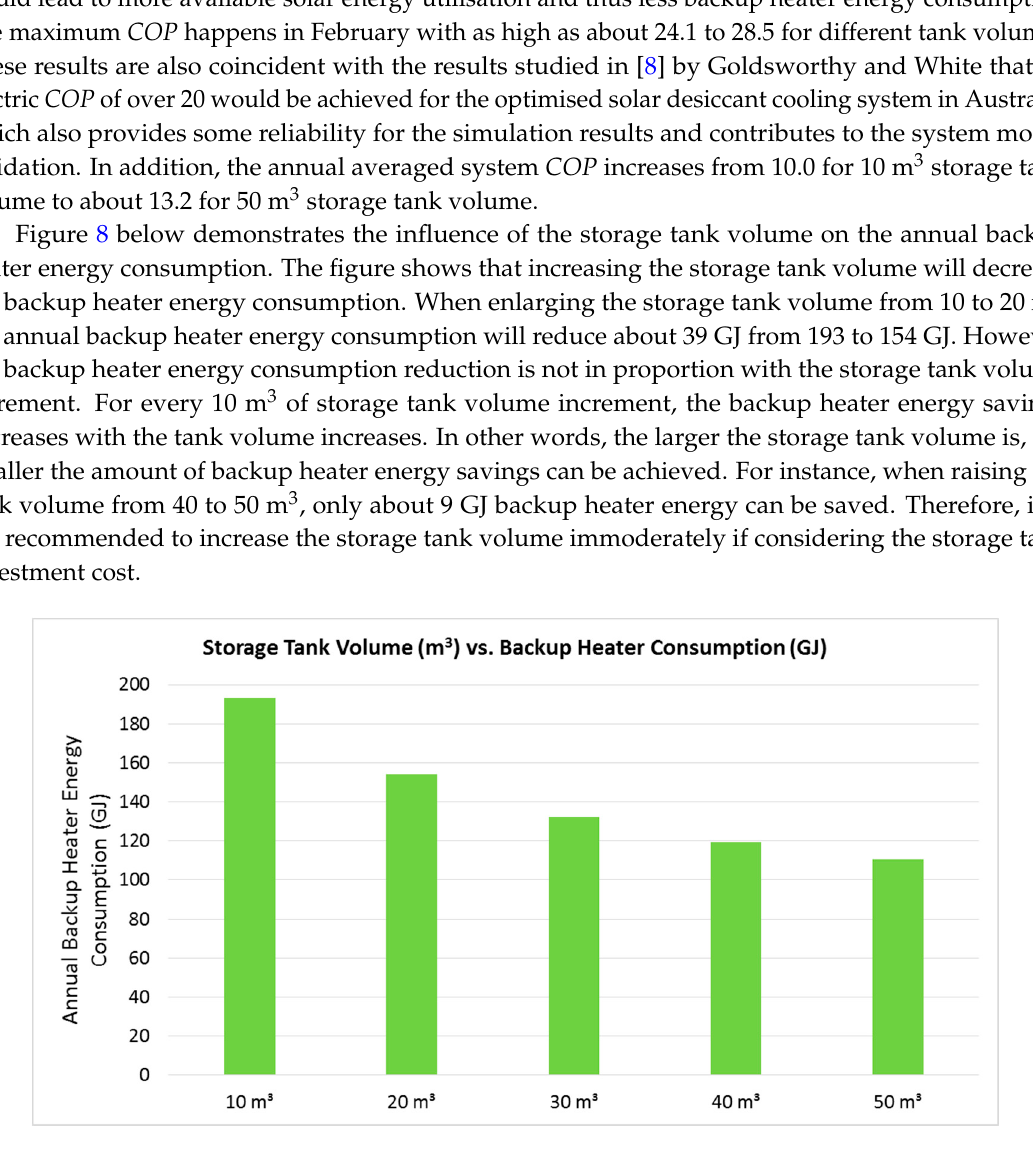
Figure 9. The impact of the solar collector area on solar fraction. Figure 9 implies that the monthly SF rises with the increase of the solar collector area. When improving the installed solar collector area from 576 to 684 m 2 , the average annual SF could boost from